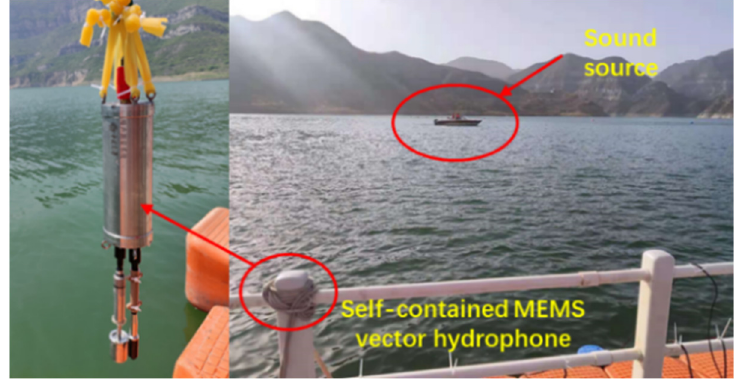
Figure 17. Experimental field of ship noise acquisition.